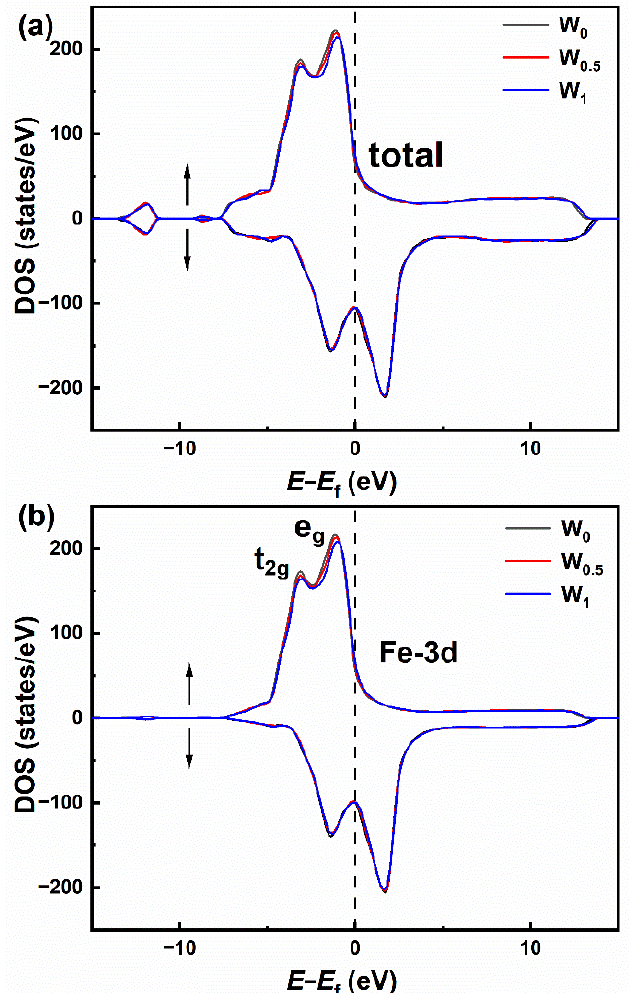
Figure 8. ( a ) Total electron DOS and ( b ) partial electron DOS of Fe atoms (3d orbital) in the Fe 86 − x P 11 C 2 B 1 W x (x = 0, 0.5 and 1) amorphous alloys. The arrows indicate the spin direction of the electron.